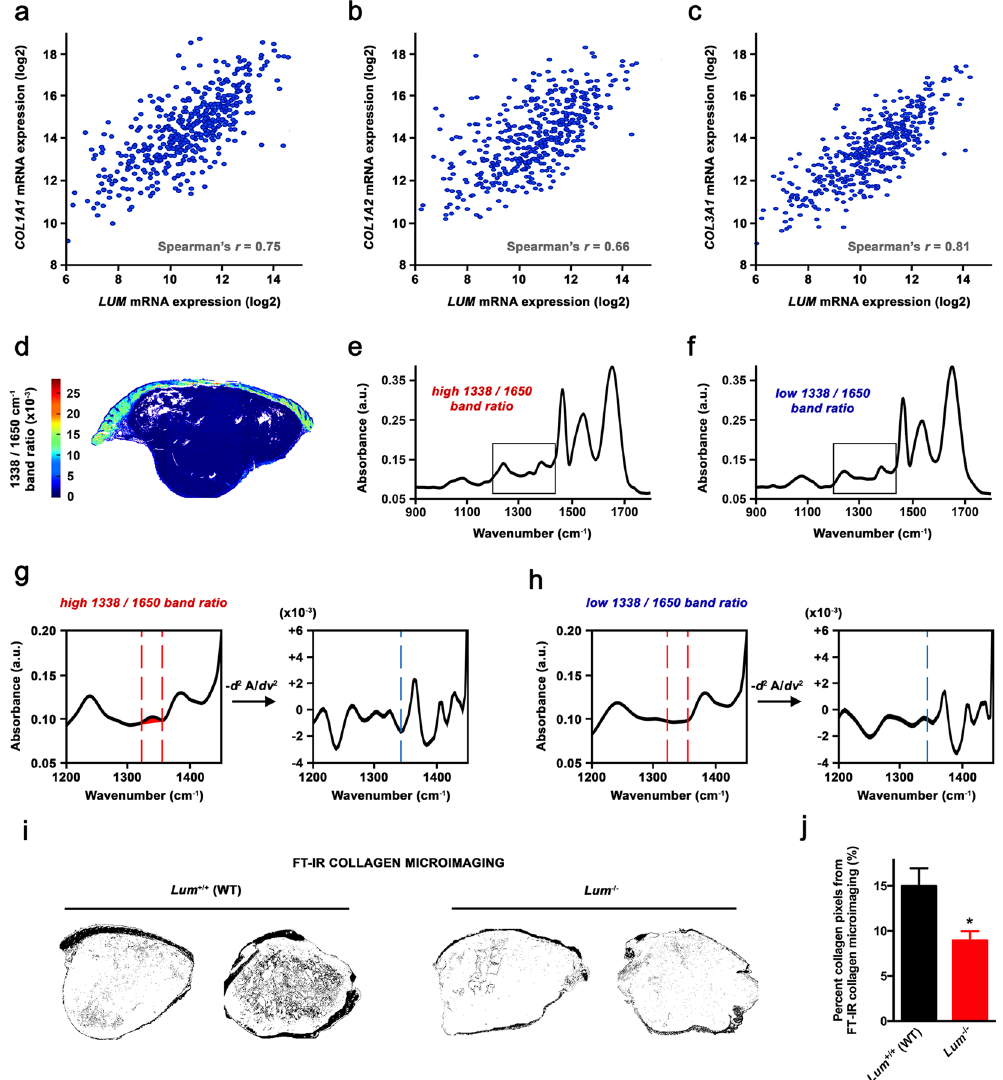
Figure 6. Investigation of the relationship between lumican and collagen deposition within tumor. ( a – c ) Levels of mRNA (z-scores) for COL1A1 ( a ), COL1A2 ( b ) and COL3A1 ( c ) genes are plotted against LUM mRNA levels in clinical samples of 473 skin cutaneous melanoma cases from the TCGA dataset. Indicated r values were calculated using Spearman’s rank correlation test. ( d – j ) FT-IR microimaging of collagen in s.c. melanoma allografts implanted in Lum + / + vs . Lum − / − mice. ( d ) Image obtained by integration on absorbance band at 1338 cm − 1 arising from collagen sidechain vibrations. Color bar indicates corresponding calculated 1338/1650 cm − 1 ratio. ( e – h ) Representative spectra for high ( e ) and low ( f ) 1338/1650 cm − 1 ratio. Insets focus on the 1200–1450 cm − 1 spectral range that is displayed in ( g ) and ( h ), showing the area of integration for 1338 cm − 1 absorbance in left panels . Right panels display corresponding second derivative spectra so as to facilitate peak identification ( blue dotted line ). ( i ) Representative binary images separating collagen from the rest of the tumor tissue after FT-IR microimaging of collagen deposition (1338 cm − 1 area). ( j ) Quantification of the number of collagen pixels relative to total tumor pixels (%) implanted in Lum + / + (WT) vs . Lum − / − mice (mean ± SEM, t test, * p < 0.05), as performed using ImageJ